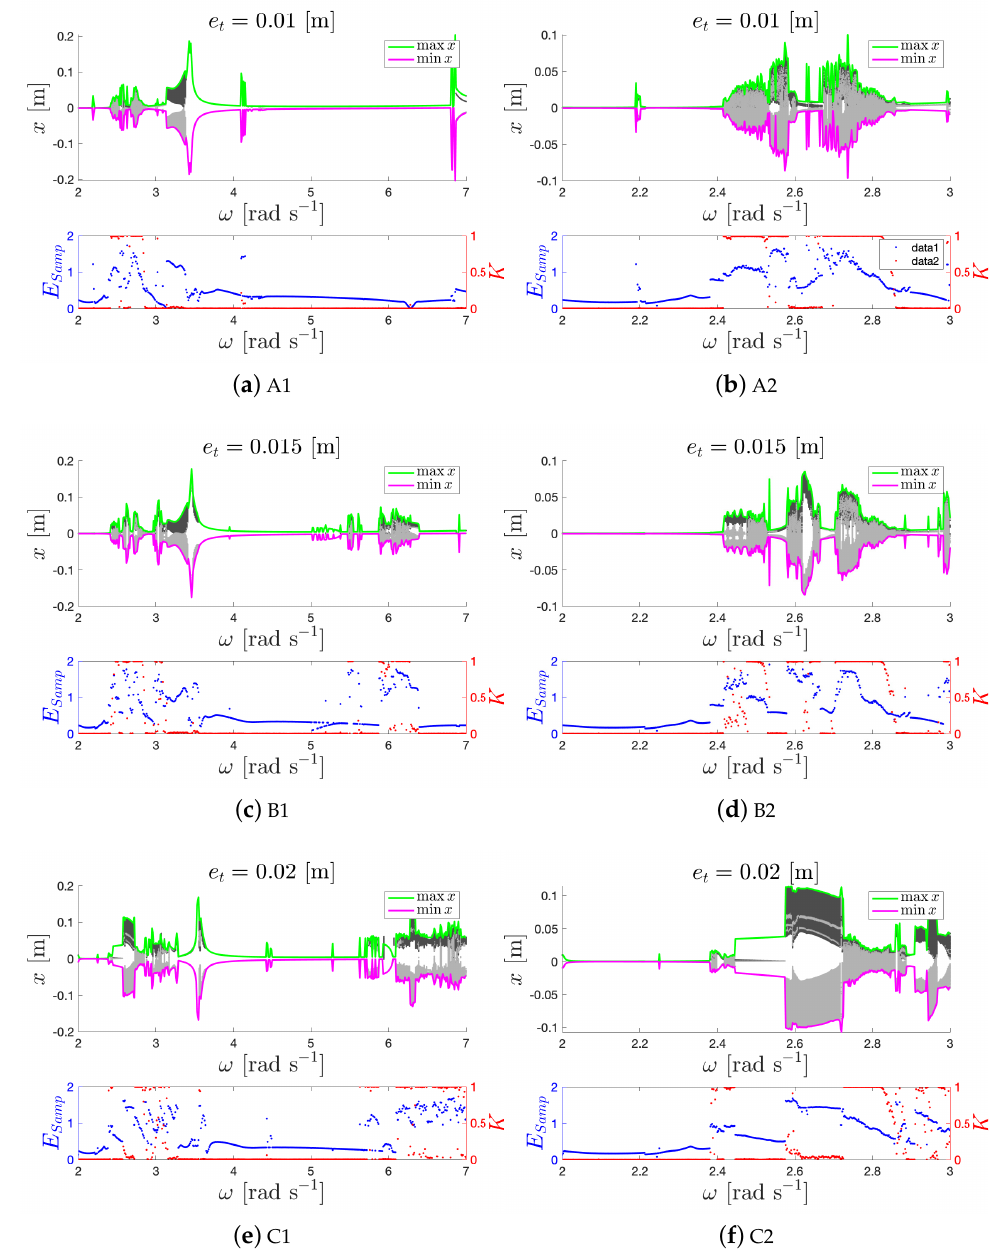
Figure 16. Bifurcation diagrams and outputs of the 0–1 test for chaos K and sample entropy E Samp of x for z a = 0.008 m with respect to the excitation frequency ω rad s − 1 of the sliding body: the first- column cases correspond to ω ∈ [ 2,7 ] rad s − 1 while the second-column cases to their magnifications ω ∈ [ 2,3 ] rad s − 1 , and “A”, “B”, “C” to eccentricity e T of 0.01 m, 0.015 m, and 0.02 m,